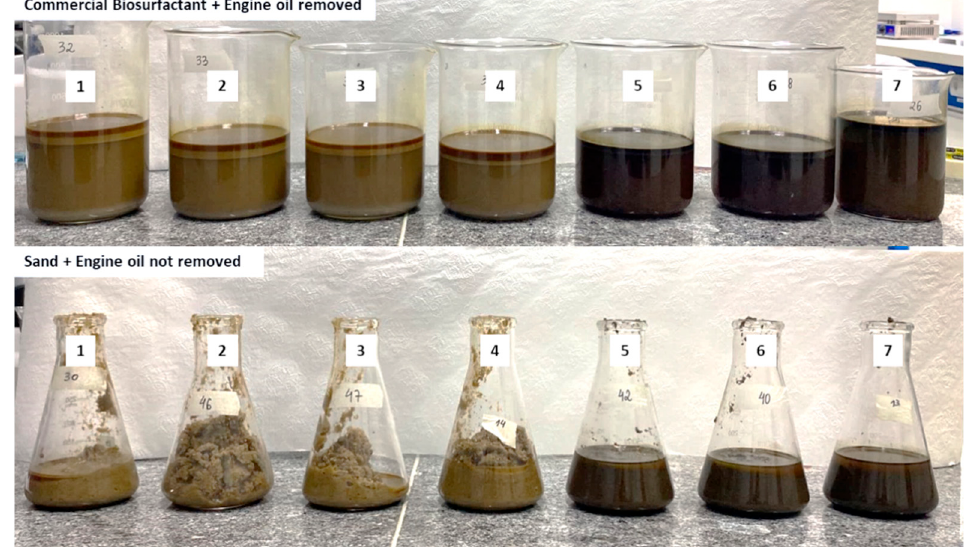
Figure 9. Images of washing solutions containing commercial surfactant ( top ) and sand ( bo tt om ) after contaminant removal runs carried out according to the full factorial design. Numbers (1–7) correspond to experimental